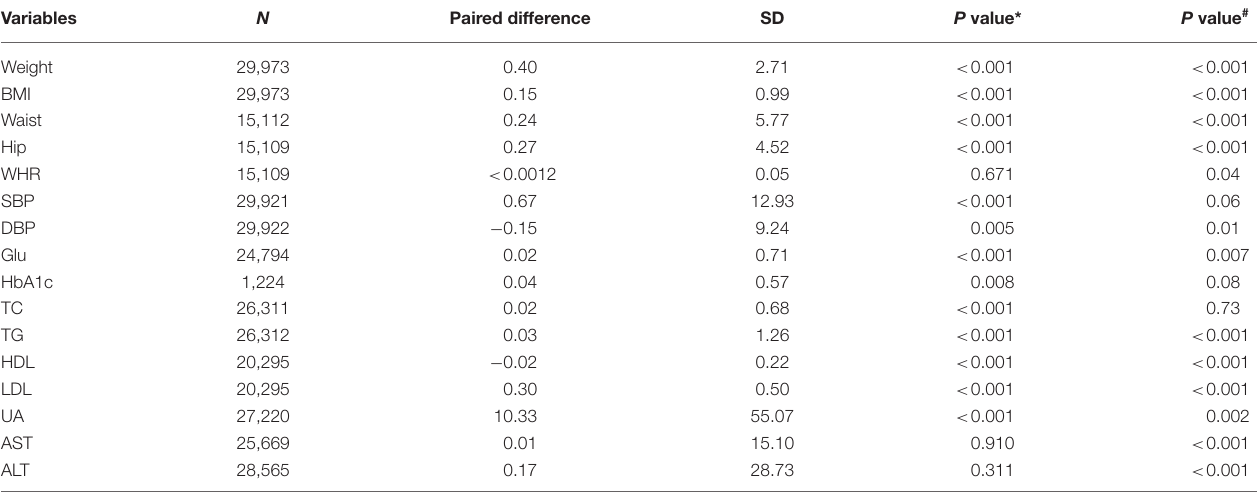
TABLE 2 | Paired difference of cardiometabolic markers between 2019 and 2020. Variables N Paired difference SD P value* P value #